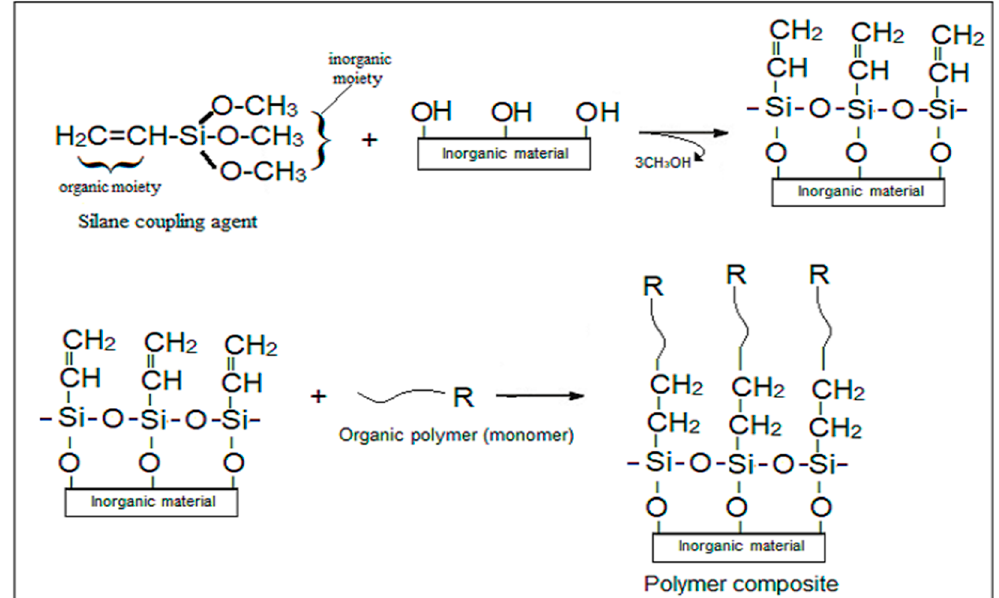
Figure 2. Synthesis of polymer composite upon functionalization of inorganic materials (such as metal oxides nanoparticles) with silane coupling.